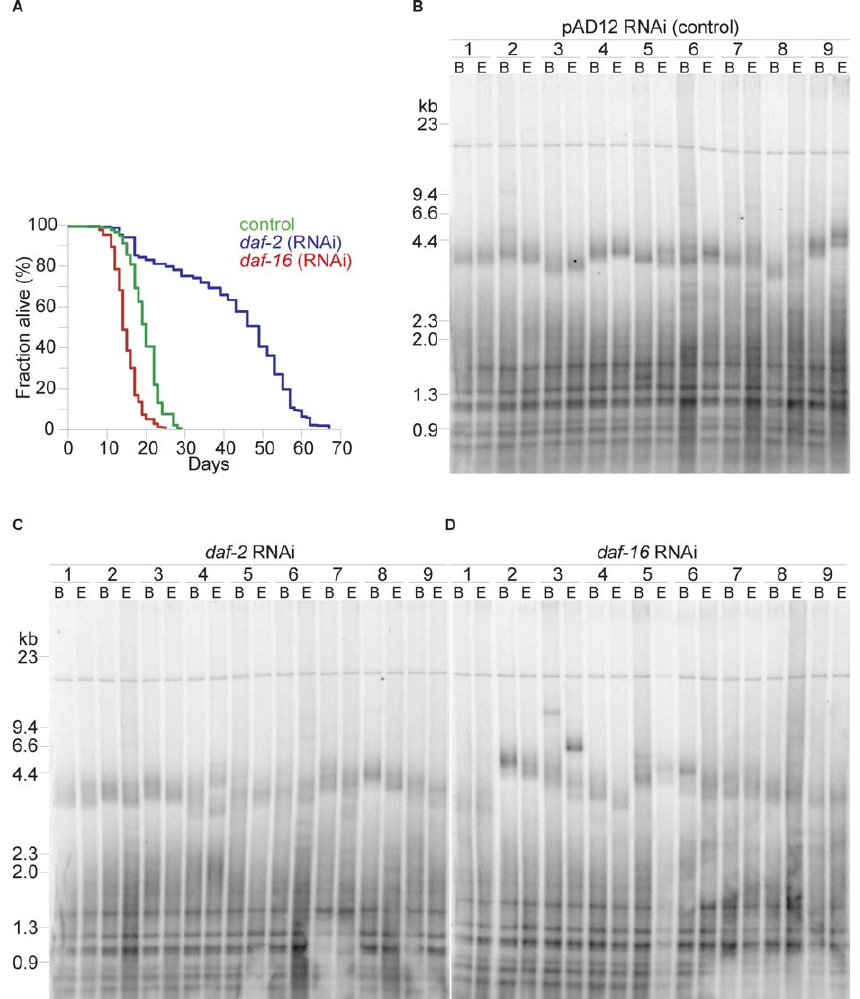
Figure 2. Organismal Life Span Is Independent of Telomere Length (A) Life span of N2 worms under control (green), daf-2 (blue), and daf-16 (red) RNAi suppression conditions. Worms were grown on bacteria expressing RNAi constructs targeting the indicated genes, and life span was assessed as described [21]. (B) Telomere length of nine individual control N2 clones was assessed as described. Samples were collected at the beginning (B) and end (E) of the experiment, and fragment size is indicated in kb. (C) Telomere length of nine individual daf-2 (RNAi) N2 clones was assessed as described in (B). (D) Telomere length of nine individual daf-16 (RNAi) N2 clones was assessed as described in (B). DOI: